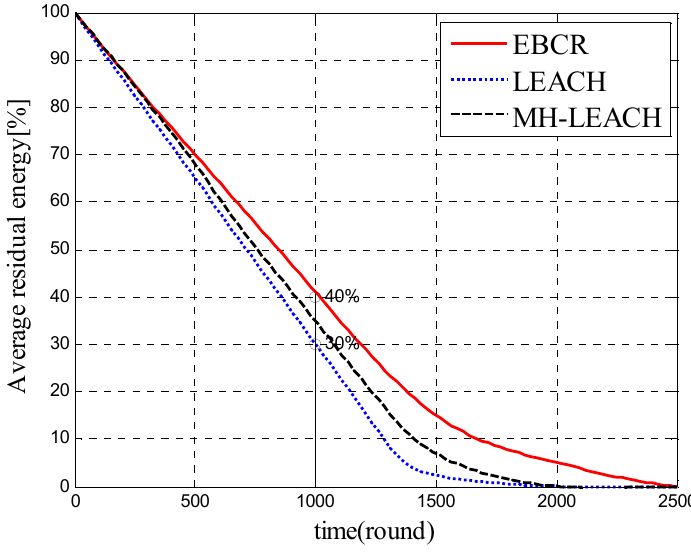
Figure 11. Comparison of average remaining energy.